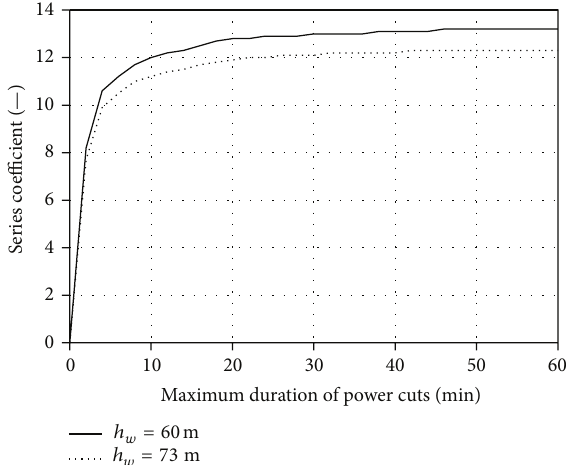
) for Enercon MAX 100kW for the period MIN